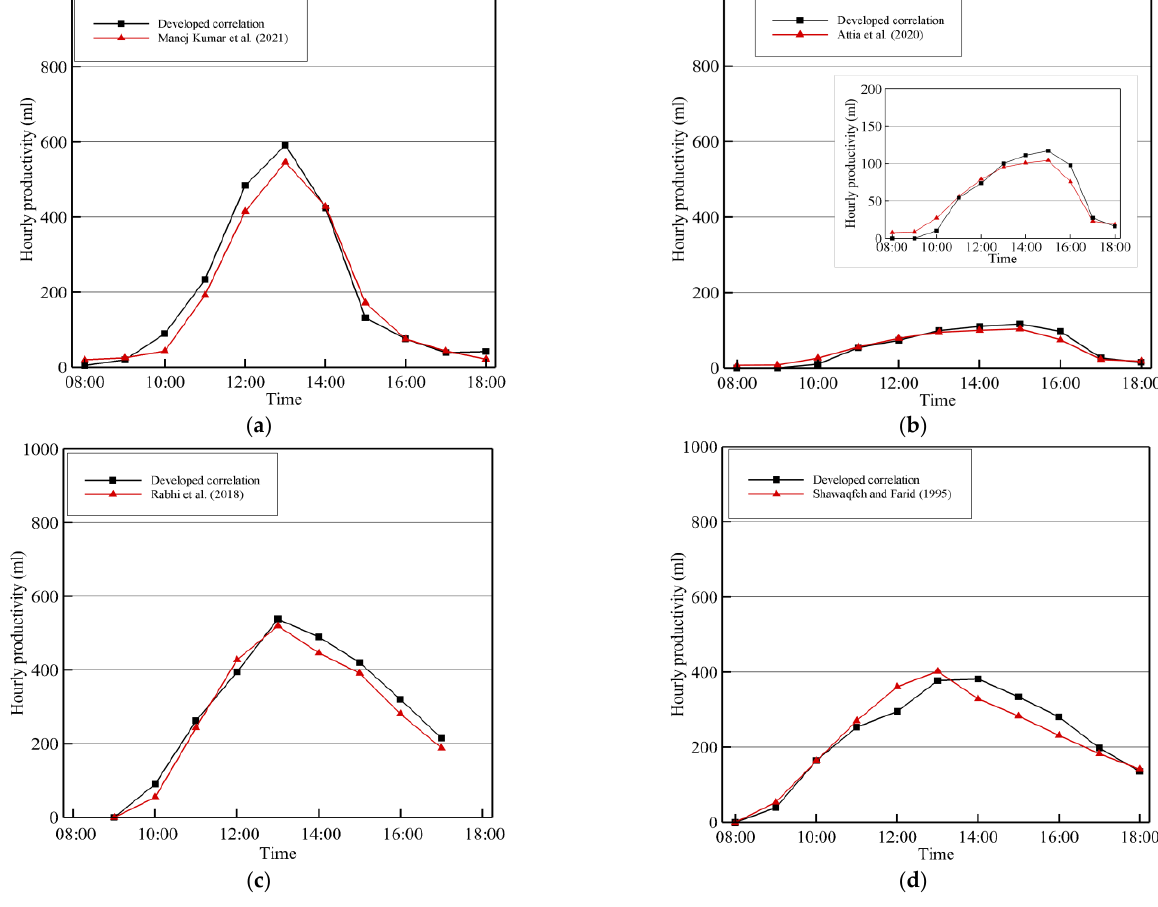
Figure 18. Predicted hourly yield against measured data, ( a ) Manoj Kumar et al. [59], ( b ) Attia et al. [60], ( c ) Rabhi et al. [58], ( d ) Shawaqfeh and Farid